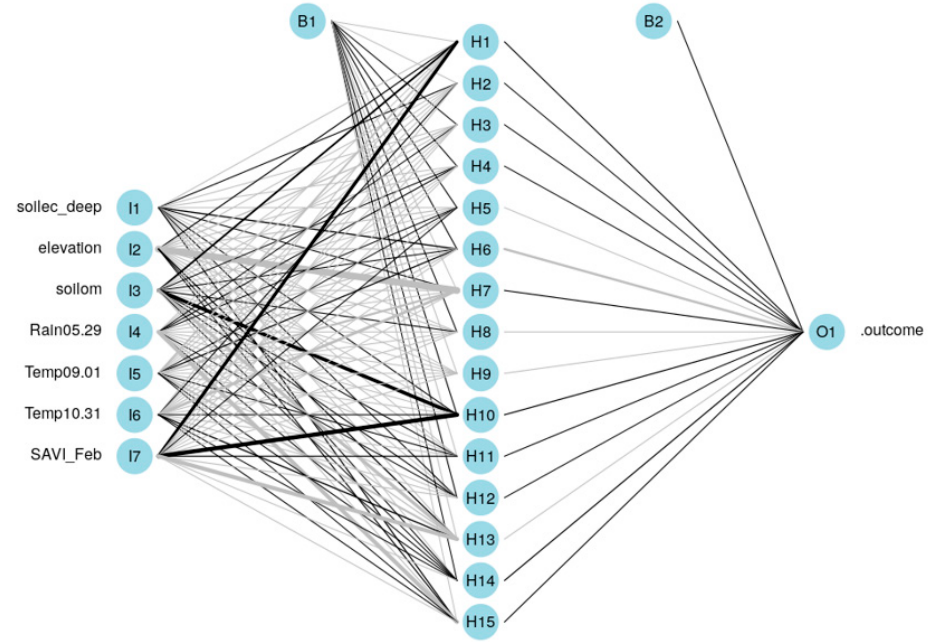
Figure 9. Illustration of a single hidden layer feed-forward neural network (the black lines are positive weights and the grey lines are negative weights. Line thickness is in proportion to the magnitude of the weight relative to all others. The input variables are shown in the first layer (labelled as I1-I8) and the response variable (yield) is shown in the far-right layer (labelled as O1). The hidden layer is labelled as H1–H15. B1 and B2 are bias layers that apply constant values to the nodes).